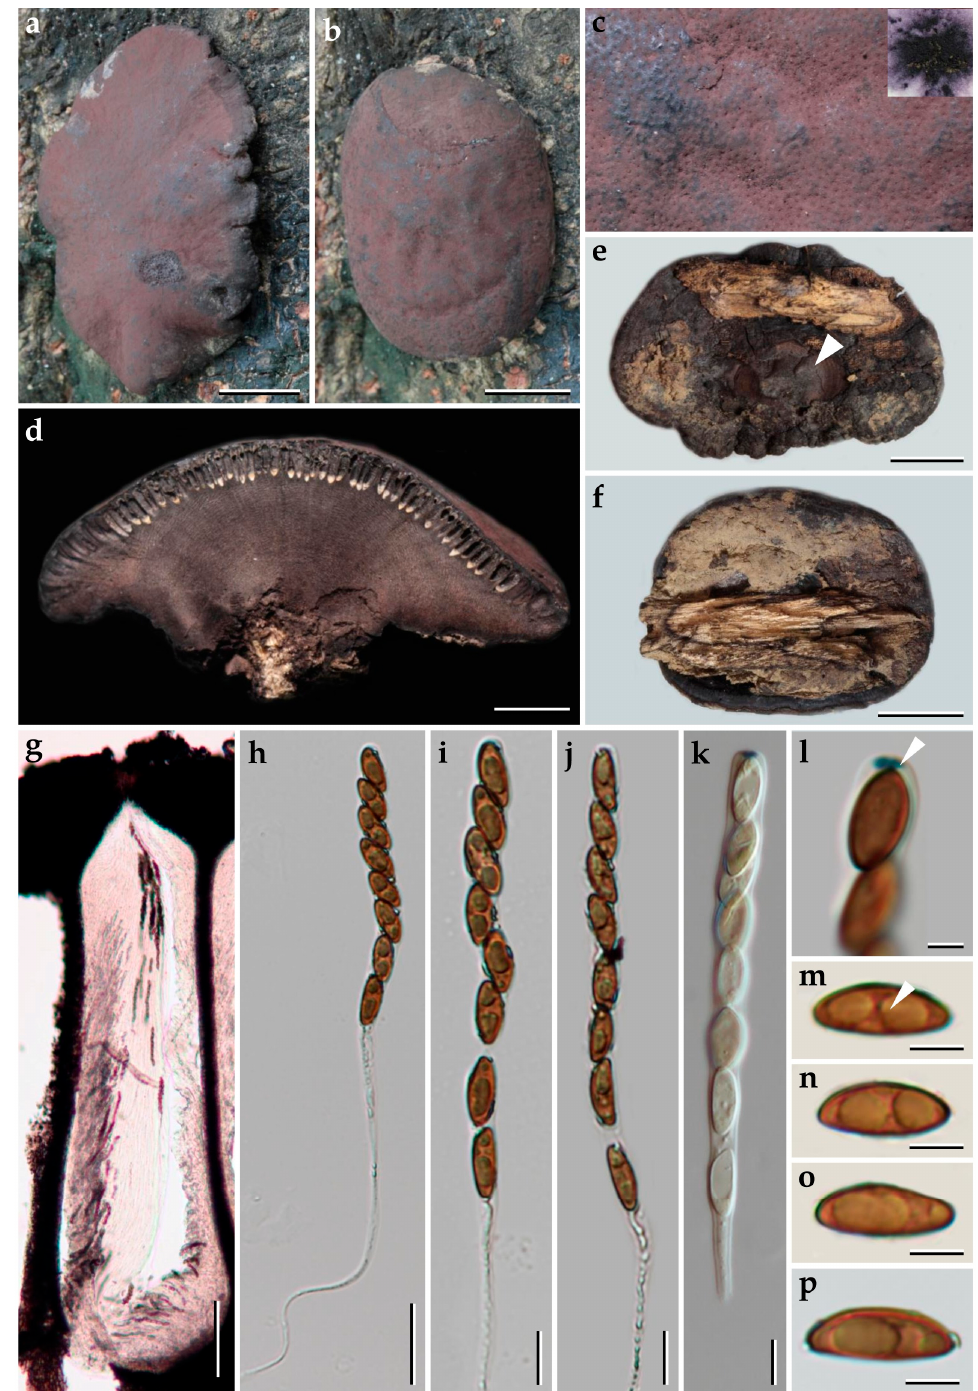
Figure 12. Morphological characteristics of Pyrenopolyporus tonngachangensis (BBH25392); ( a – d ) stroma on natural habit; ( c ) stromal surface and ostioles with KOH-extractable pigments in 10% KOH; ( d ) longitudinal section of stroma showing perithecia and the tissue below the perithecial layer; ( e , f ) detail of stromal insertion point (white arrow); ( g ) longitudinal section perithecia under the light microscope; ( h – j ) asci in distilled water; ( k ) young ascus in Melzer’s reagent; ( l ) apical apparatus, bluing in Melzer’s reagent (black arrow); ( m ) ascospore showing germ slit (white arrow); ( n – p ) ascospores. Scale bars: ( a , b , e , f ) = 1 cm; ( d ) = 0.5 cm; ( h ) = 20 µm; ( i – k ) = 10 µm ( l – p ) = 5 µm.